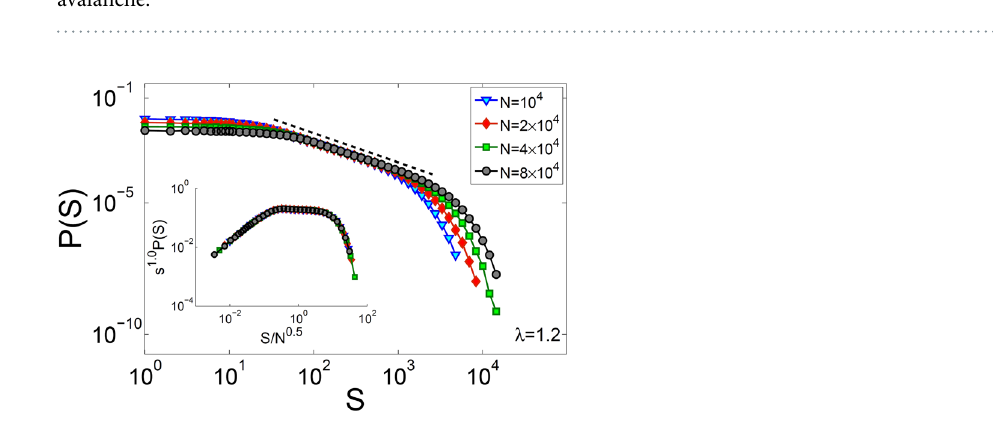
Figure 6. Main panel: probability distribution functions of avalanche sizes for systems with λ = 1.2 and different values of N . Inset panel: plots of rescaled data, collapsed into one universal curve with τ S = 1.0 and = β S